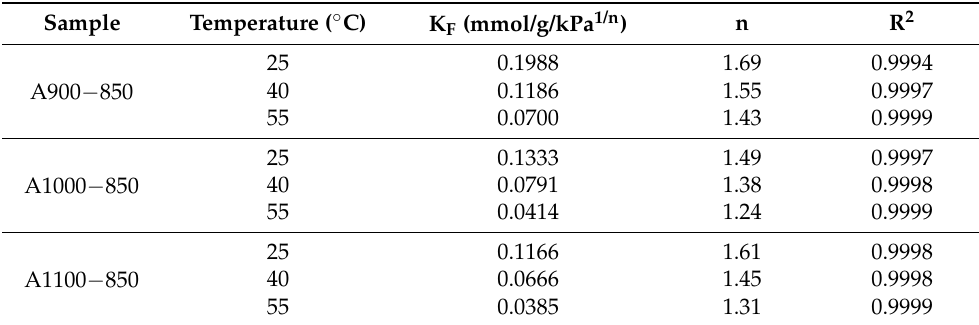
Table 6. Fitted results of Freundlich equation for the CO 2 adsorption data for the samples at different temperatures.